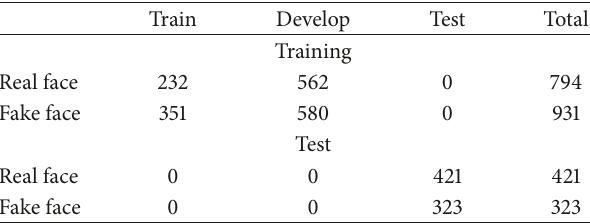
Table 3: Number of pictures on the REPLAY dataset.